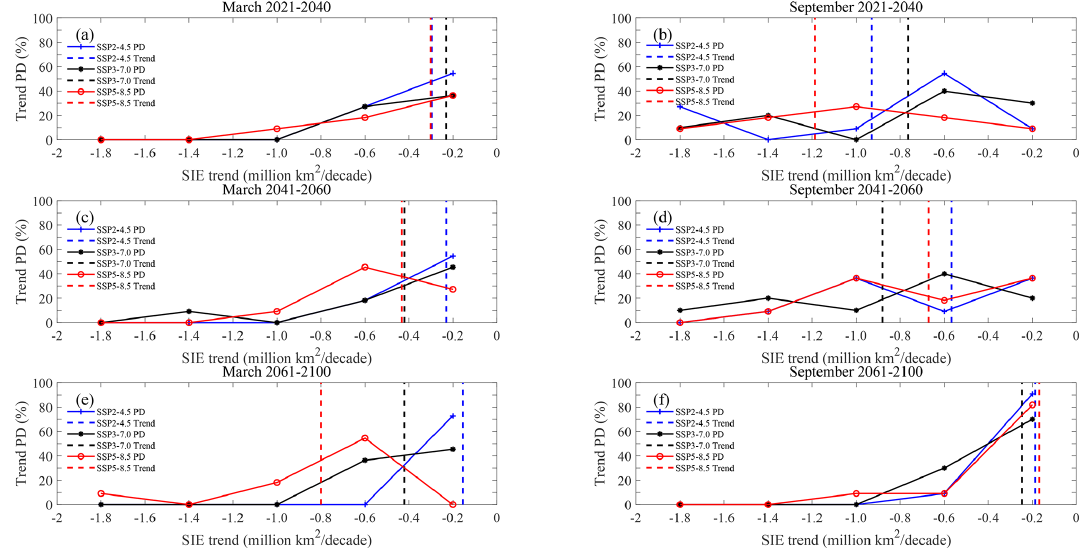
Figure 3. Linear trends and probability distributions (PDs) of Arctic sea ice extent (SIE) in March and September.